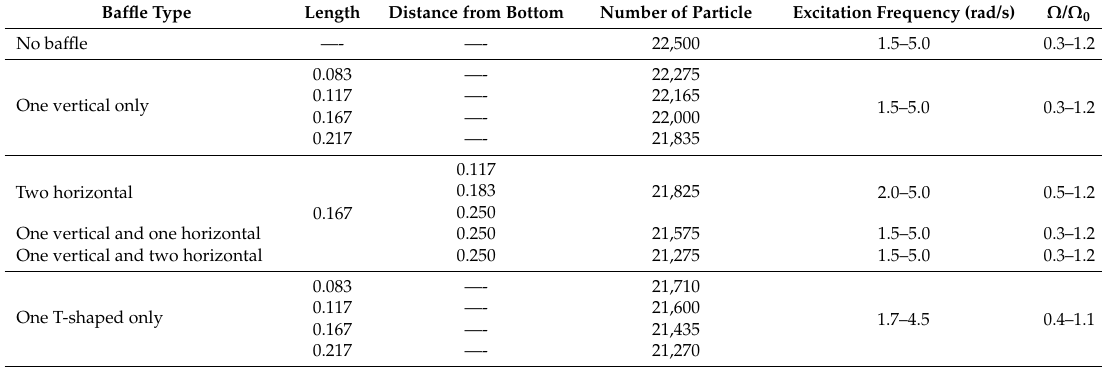
Table 2. Summary of different baffle configurations and external excitation conditions.